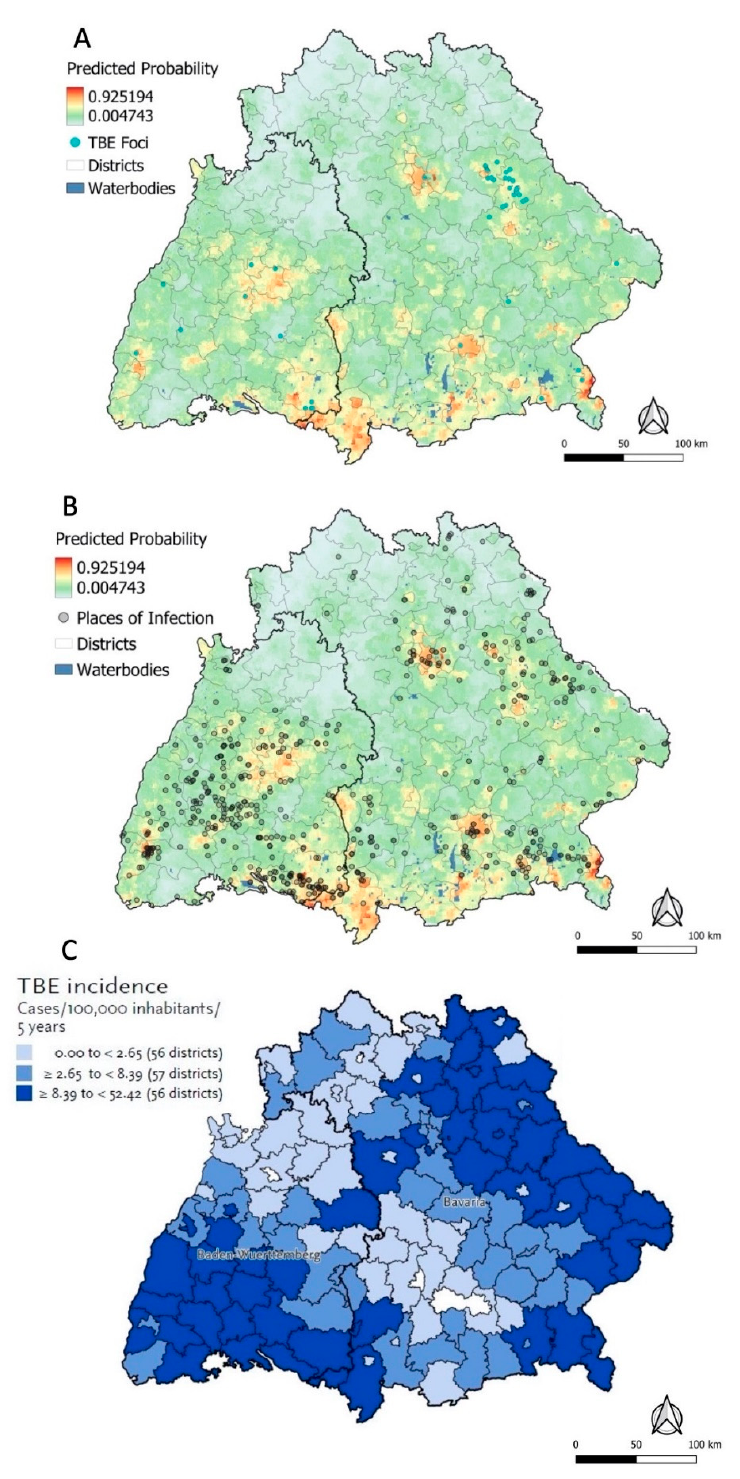
distribution of the actual POI and TBE foci (Figure 5B). The binary risk map superimposed with POI and TBE foci further confirms this observation (Figure S4).